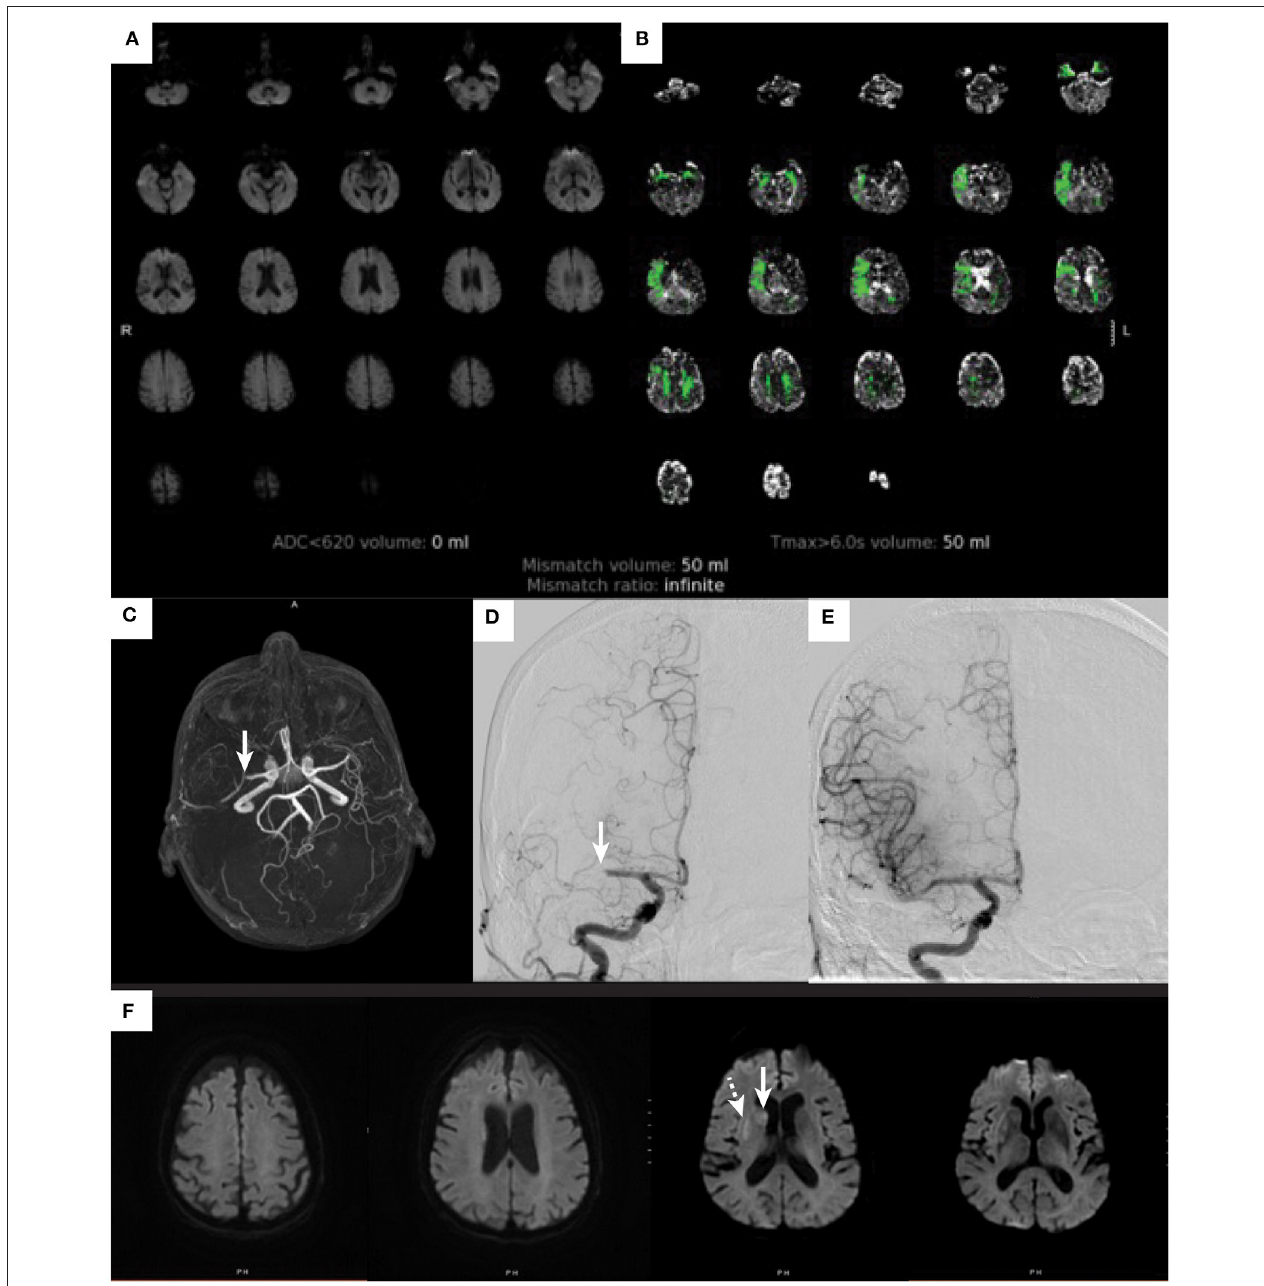
FIGURE 1 | Ischemic stroke in an elderly patients with mild symptoms. An 81-year-old woman with atrial flutter on apixaban, hypertension, hyperlipidemia, and baseline modified Rankin score of 0 developed acute onset left facial droop with dysarthria and left hand weakness. These symptoms lasted for about 20min and then completely resolved by the time she arrived to the emergency department. On initial examination she had an NIHSS score of 0. She was not treated with IV alteplase due to resolution of symptoms. A diffusion-weighted image (A) does not show any evidence of cerebral infarction (ADC < 620 volume 0), and